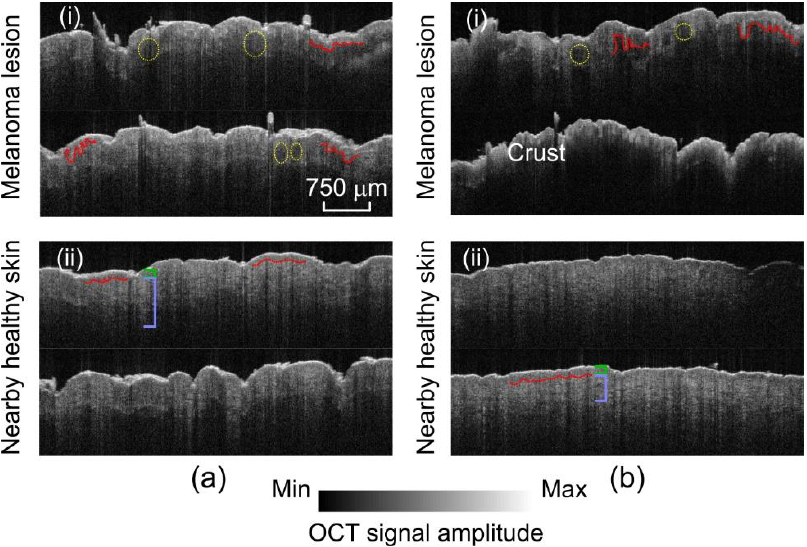
Figure 5. OCT images of melanoma lesion and nearby healthy skin. ( a ) Abdominal: (i) Lesion and (ii) healthy. ( b ) Flank: (i) Lesion and (ii) healthy. Melanomas demonstrate disorganization and thickening of the epidermis, larger rete ridges, an obscured dermal–epidermal junction (DEJ), and dermal tumor nests. Yellow circles: Dermal nests of melanocytes. Red lines: Dermal–epidermal junction. Green brackets: Epidermis. Light blue brackets: Dermis.